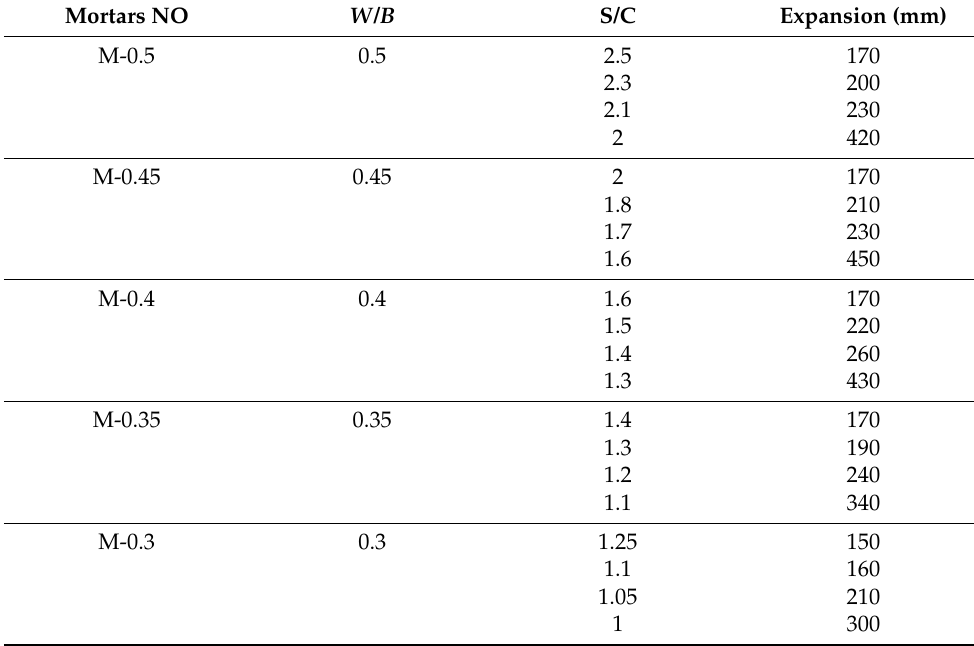
Table 5. The relationship between expansion and sand-cement ratio under different w/b